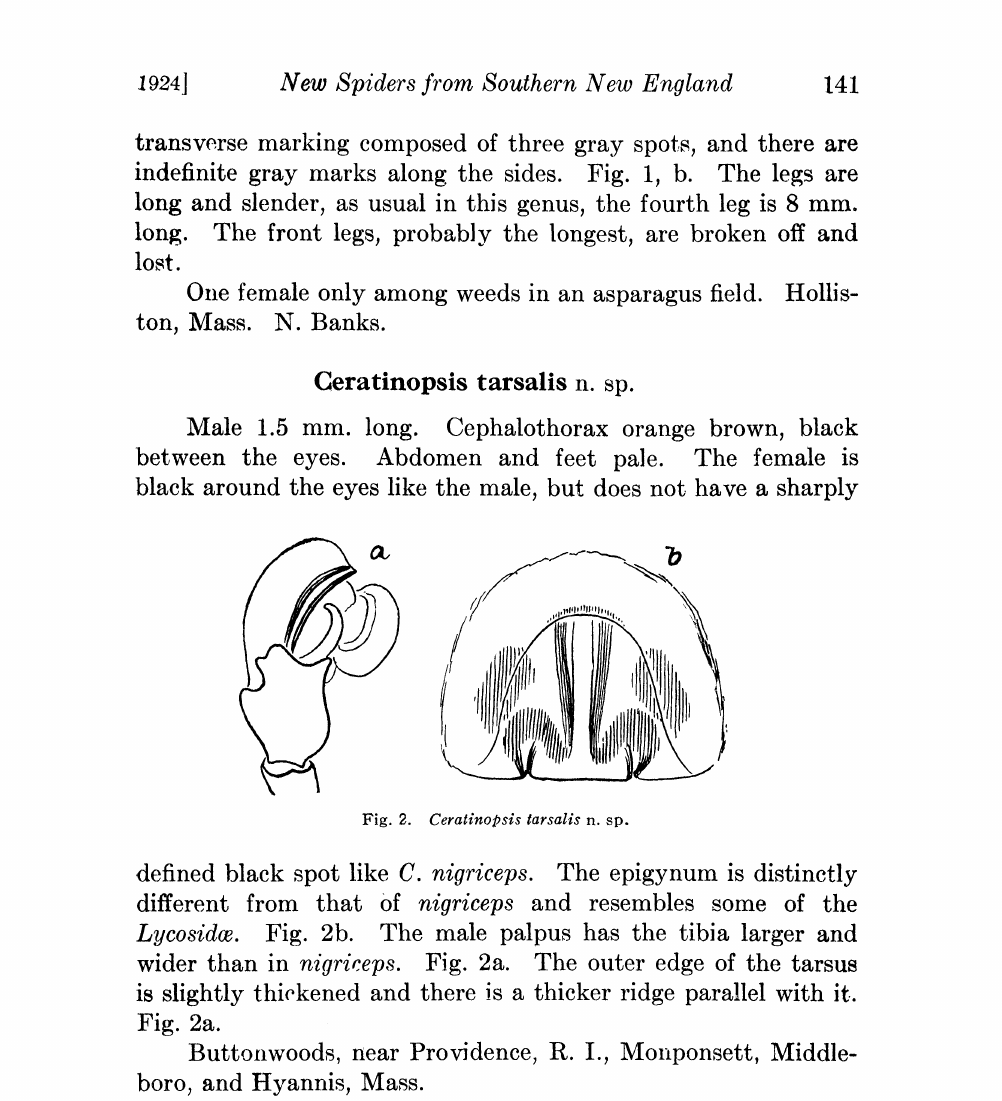
Fig. 2. Ceratinopsis tarsalis sp.